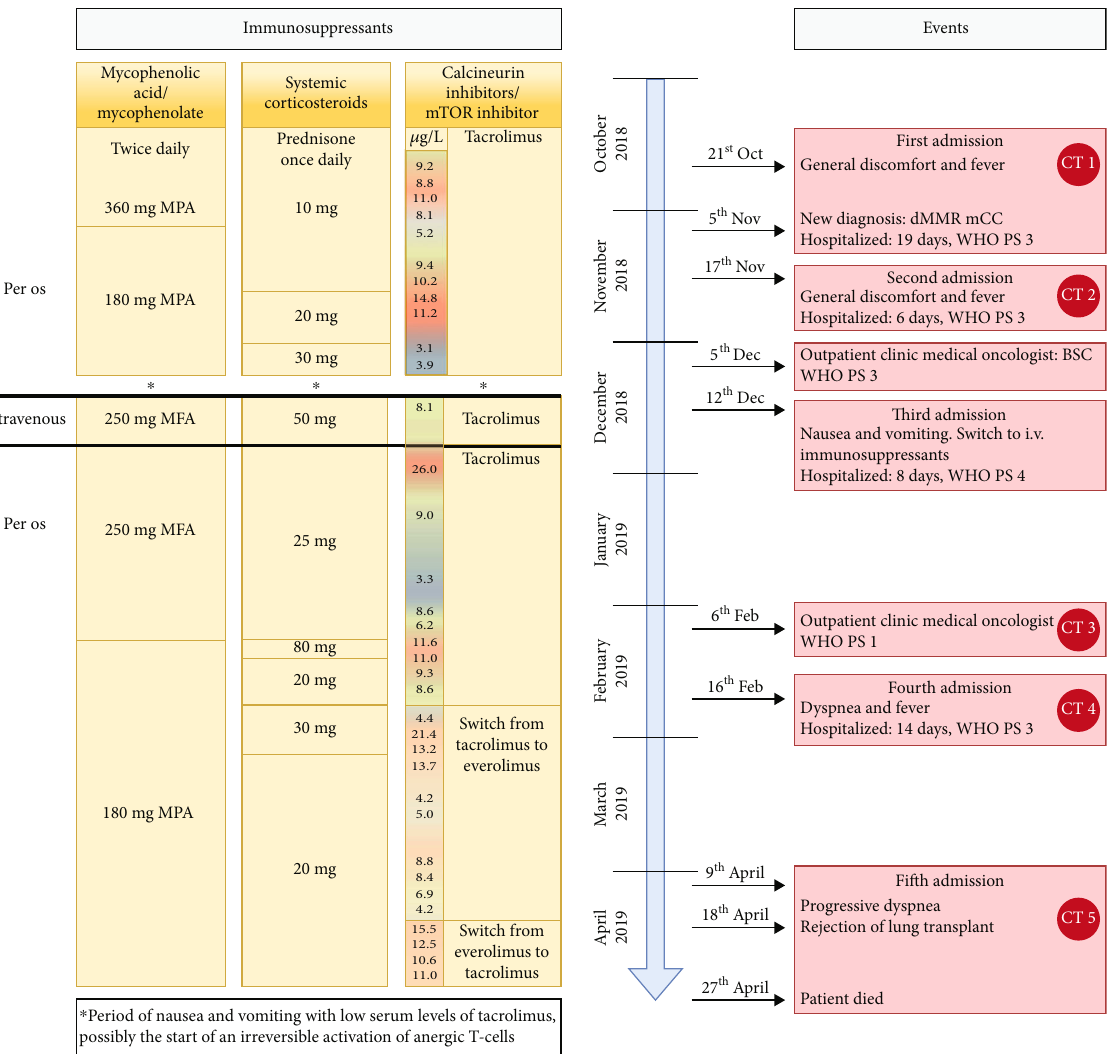
Figure 1: Timeline with dose of immunosuppressants and events. Target trough levels of tacrolimus and everolimus were 7-8 μ g/L and 6- 8 μ g/L, respectively, with blue coloring for subtherapeutic levels, green for therapeutic levels, and red for supratherapeutic levels. Abbreviations: dMMR = de fi cient mismatch repair; i.v. = intravenous; mCC = metastatic colon cancer; MFA = mycophenolate; MPA = mycophenolic acid; MSI = microsatellite instability; mTOR = mechanistic target of rapamycin; WHO PS = World Health Organization performance score.